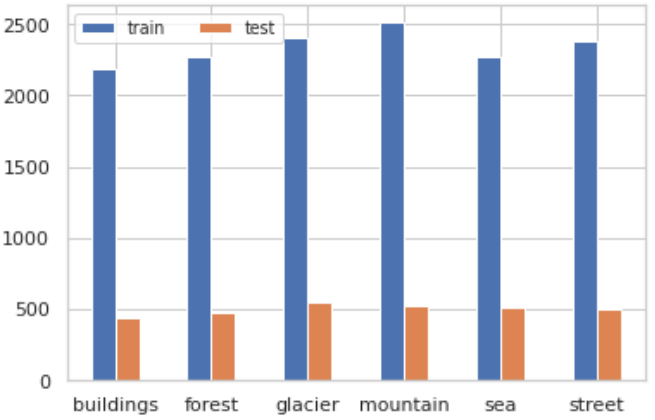
Figure A5. Training and testing labels visualization of Intel image classification dataset.